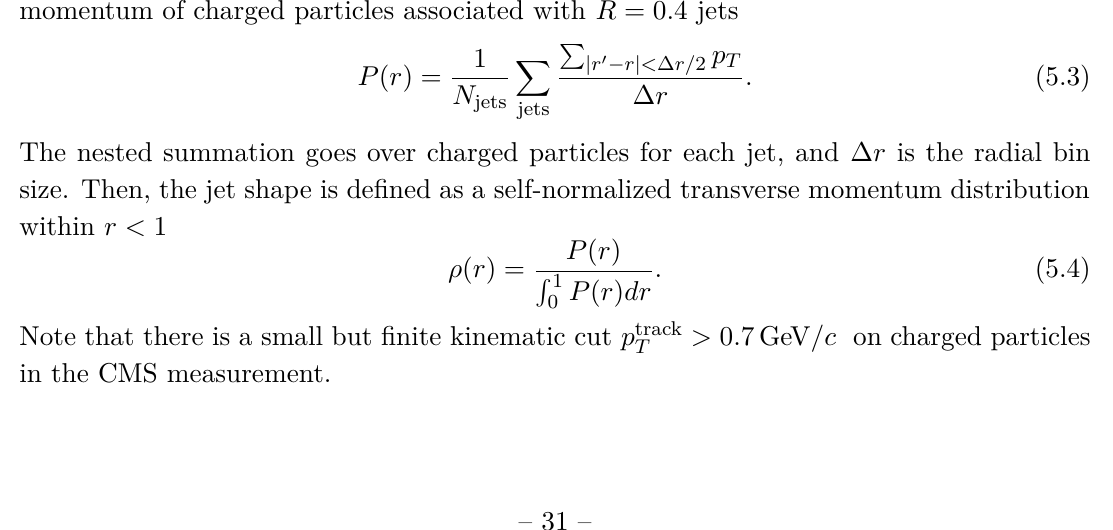
data points) are T